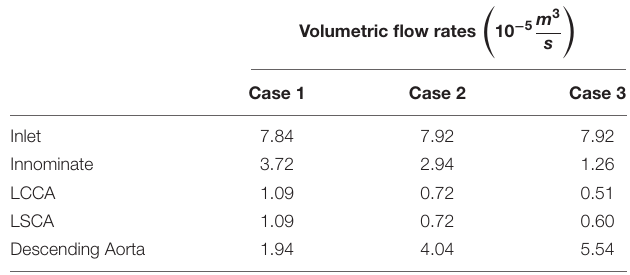
TABLE 1 | Volumetric flow rates applied as outlet boundary conditions for each case.